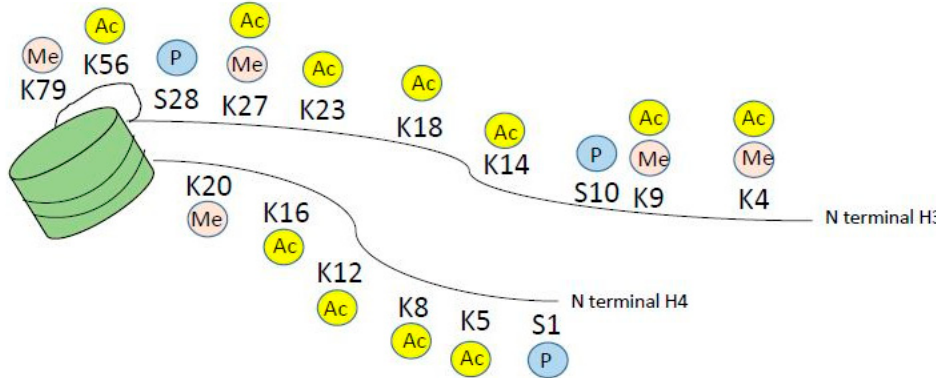
Figure 2. Histone modifications on the N terminal tail of histone H3 and H4. For simplicity, only methylation, acetylation and phosphorylation are depicted, however modifications also include arginine methylation and ubiquitination marks.